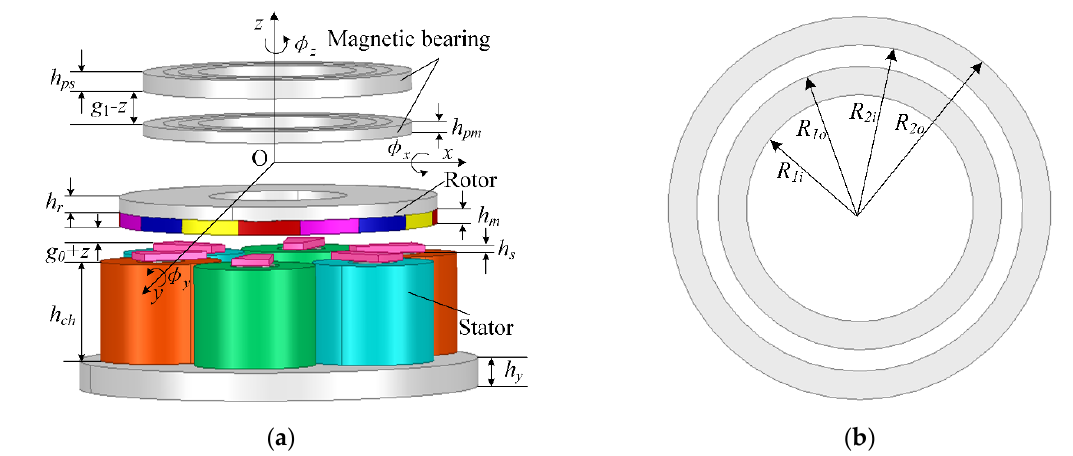
Figure 3. Hybrid magnetic suspension system with a single ‐ winding bearingless motor and a permanent magnet bearing: ( a ) Hybrid magnetic suspension system; ( b ) permanent magnet bearing.